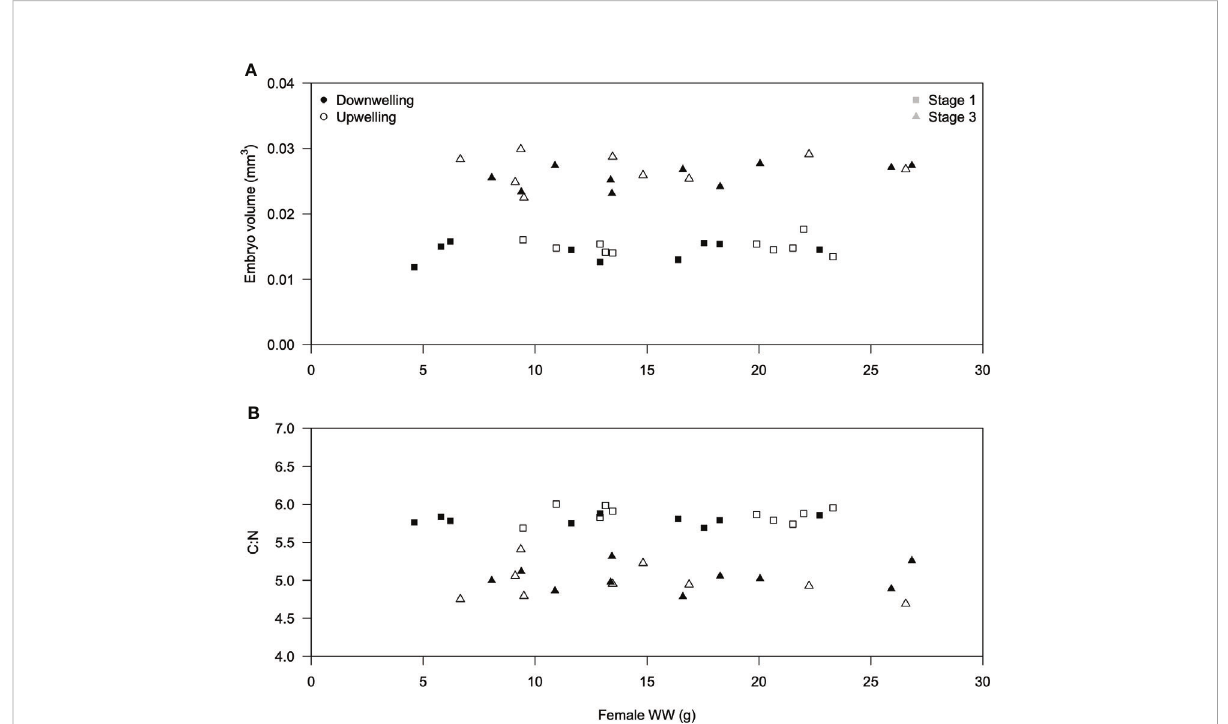
FIGURE 1 Relationship between female Carcinus maenas wet weight (g) and (A) average embryo volume (mm 3 , n = 40 females) or (B) average embryo C: N content ( n = 40 females). Females collected during downwelling are depicted with white symbols, whereas upwelling ones are shown in black symbols. Squares and triangles are used to distinguish between stage 1 and stage 3 embryos,